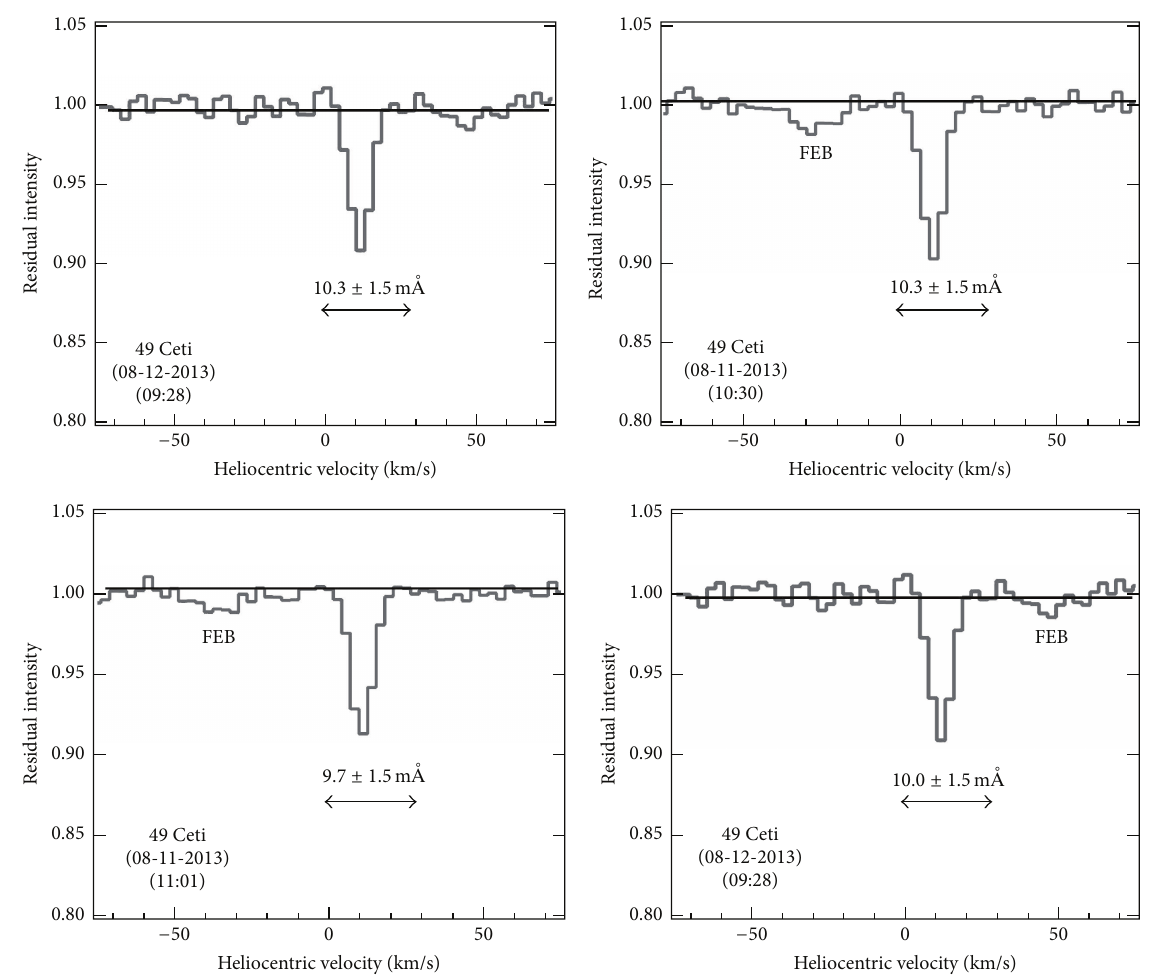
Figure 5: Circumstellar CaII K-line absorption recorded towards 49 Ceti (HD 9672) on the nights of 8-11-2013 and 8-12-2013. Times given in parentheses are U.T. Note the disappearance of the FEB event at 𝑉 ∼ −35 kms −1 on night 8-12-2013 and the appearance of a new FEB event at 𝑉 ∼ +50 kms −1